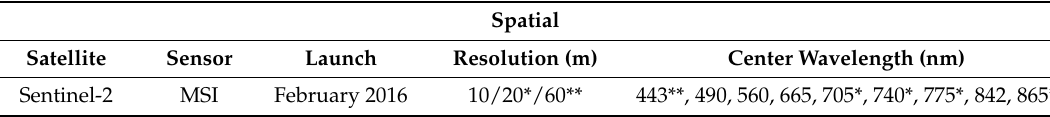
Table 3. Performance of the Sentinel-2 Multispectral Imager (MSI).